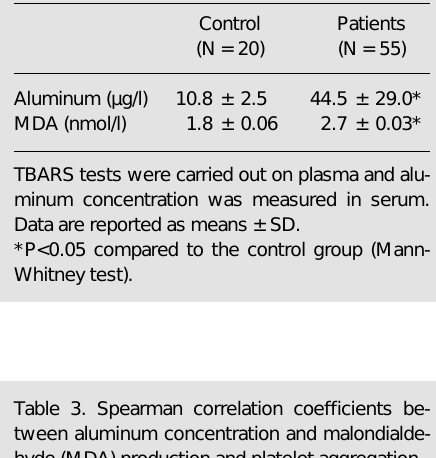
Table 3. Spearman correlation coefficients